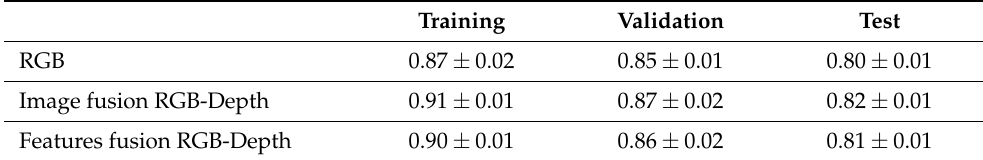
Table 3. Seedling growth stage classification average accuracy and standard deviation when per- formed over 10 repetitions of TD-CNN-GRU model.